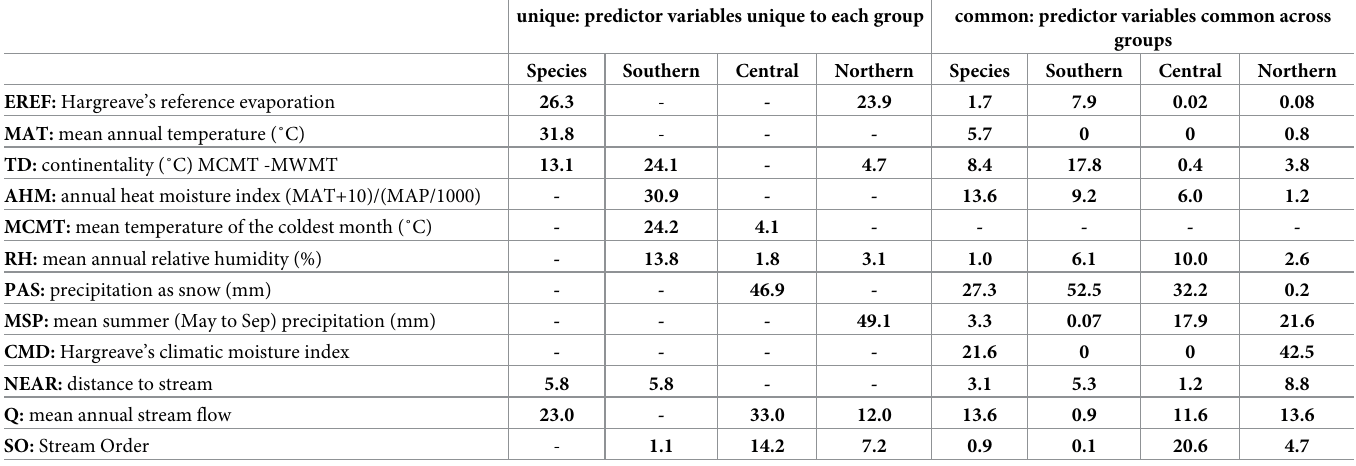
Table 2. Percent (%) contribution of environmental variables to ENMs.